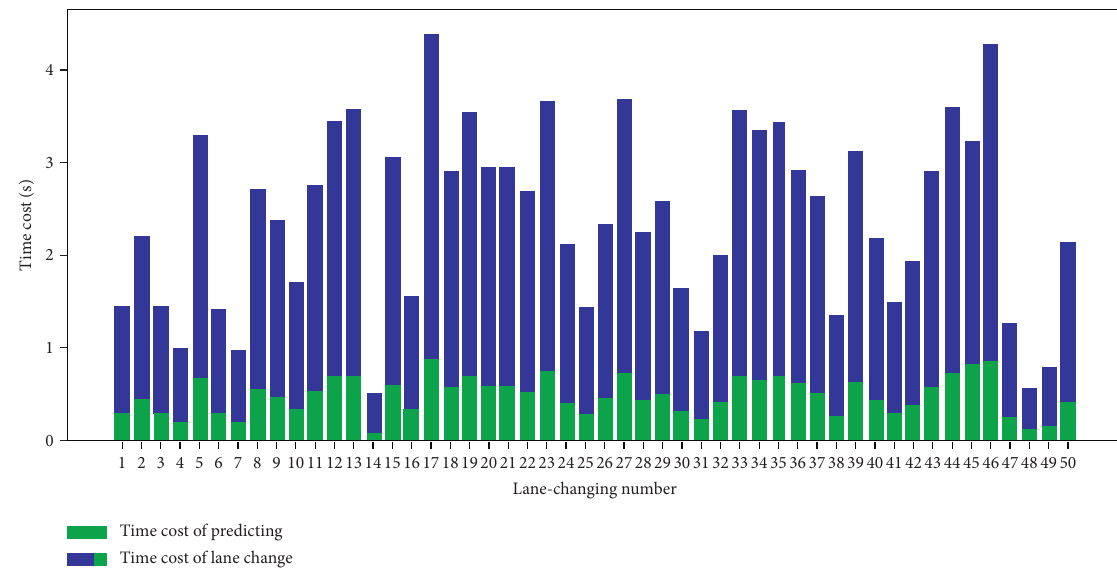
Figure 20: Time cost for different numbers of lane changes in validating. Table 6: Details of the six comparison models.